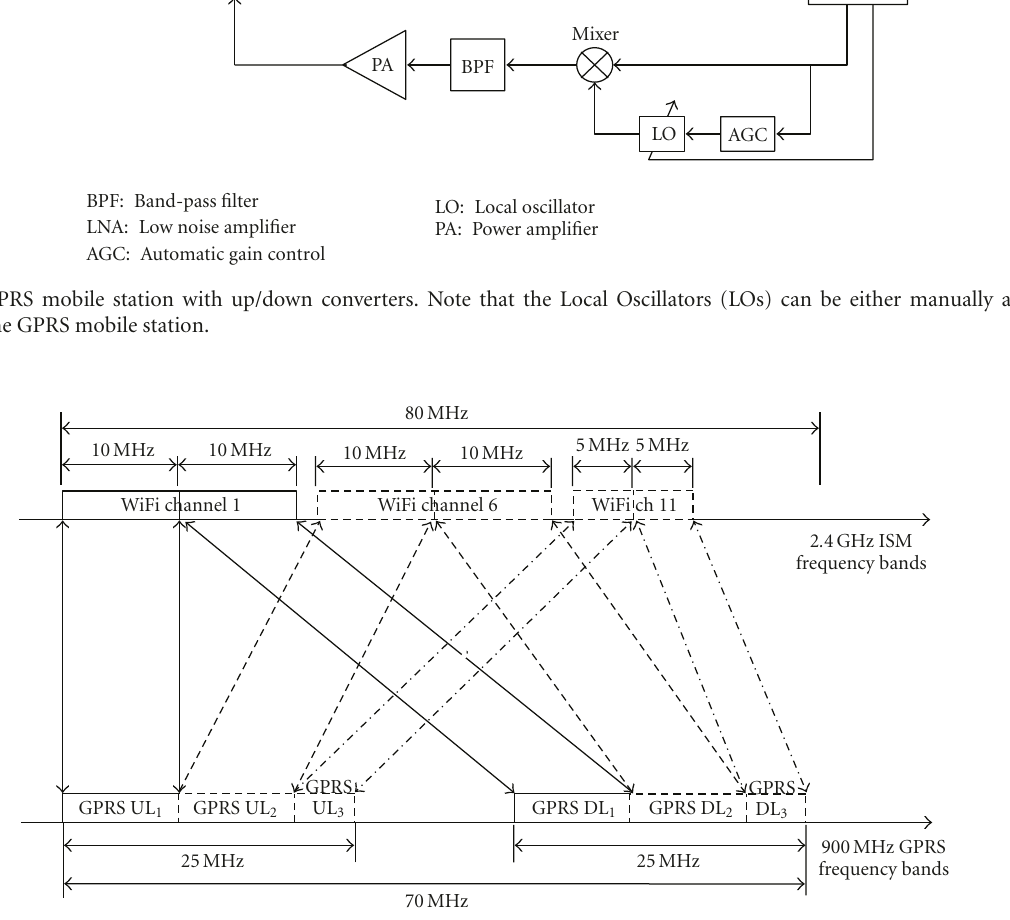
Figure 5: Frequency band mappings between GPRS DL/UL bands and WiFi channels 1, 6, and 11.